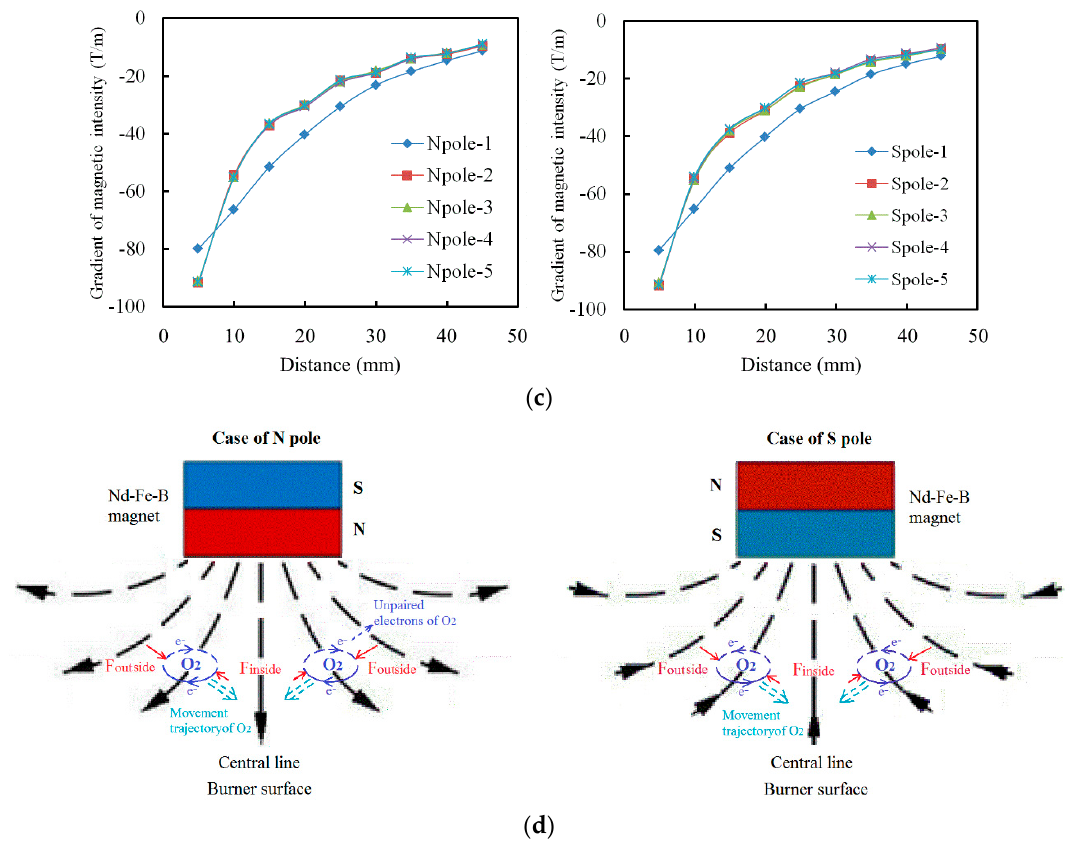
Figure 2. Schematics of the magnetic fields of Nd-Fe-B magnet. ( a ) Measurement points, ( b ) Profiles of the magnetic field intensity distributions, ( c ) Profiles of the gradient of the magnetic field intensity, ( d ) Magnetic forces of oxygen in case of N pole and S pole, respectively. Table 1. Experimental conditions of n -heptane/DMF IDF with/without magnetic fields.